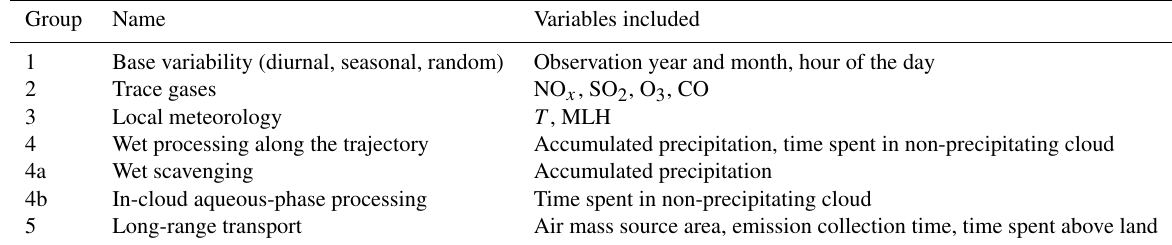
Table A1. Predictor variables used in regression.